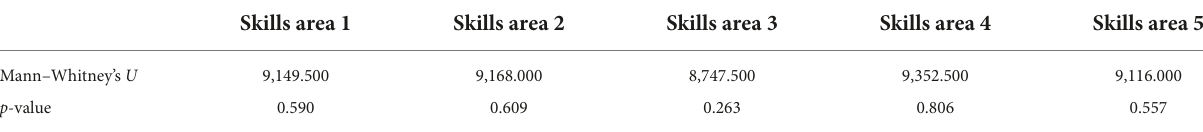
TABLE 6 Analysis of the association between gender and level of digital skills.